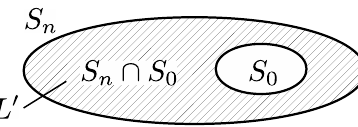
Figure 3. Decomposition of S n into S n ∩ S 0 and S 0